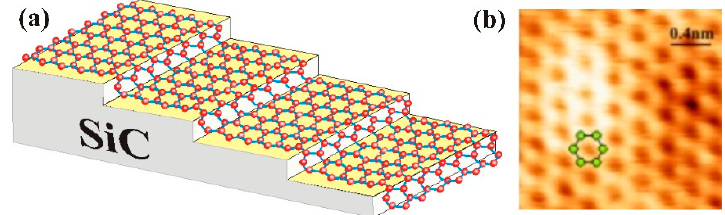
Figure 5. ( a ) A sketch of graphene layer on SiC substrate; ( b ) STM image of graphene layer grown on